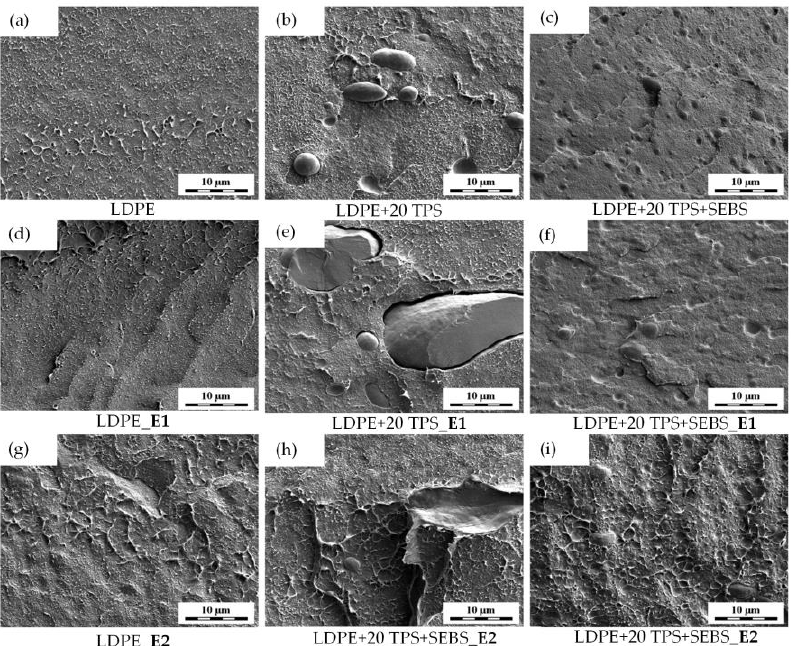
Figure 8. SEM micrographs showing fracture surface of LDPE, LDPE+20 TPS, and LDPE+20 TPS+SEBS before ( a – c ) and after degradation in experiments E1 ( d – f ) and in experiments E2 ( g – i ). Chemical changes on the surface of the LDPE, LDPE/20TPS, and LDPE/20TPS/SEBS